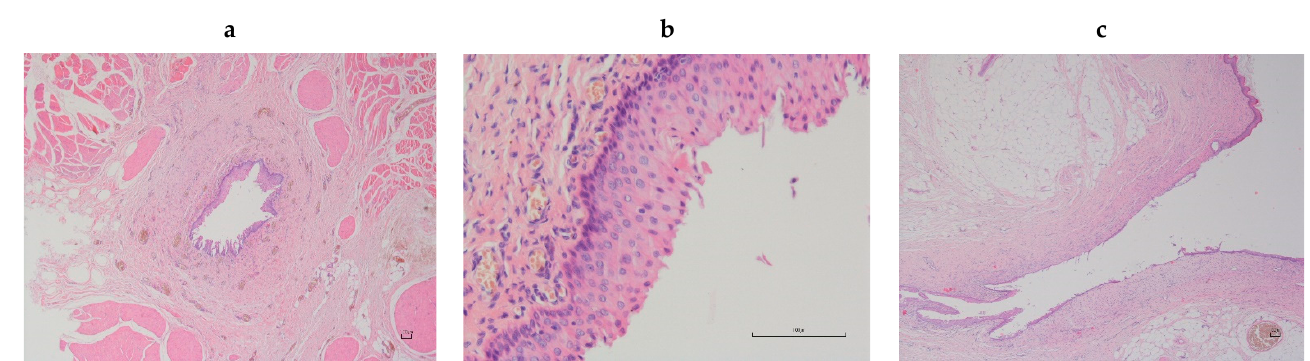
Figure 4. ( a , b )—Istological aspect of a canine accessory urethra: the urethral lumen is lined by transitional epithelium and lamina propria is characterized by a fibro vascular stroma (2X and 20X—E-E); ( c )—Meatus urinarius of the excised urethra in the present case: the urethra has a transitional epithelial lining that merges with the stratified squamous epithelium at the urethra.